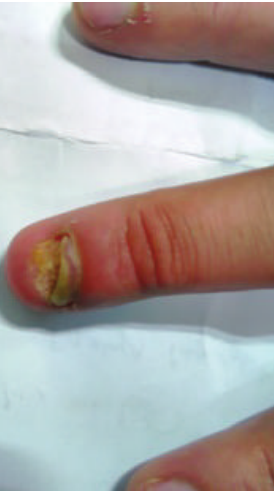
Figure 1: Left middle finger nail showing onycholysis and ony- chodystrophy.